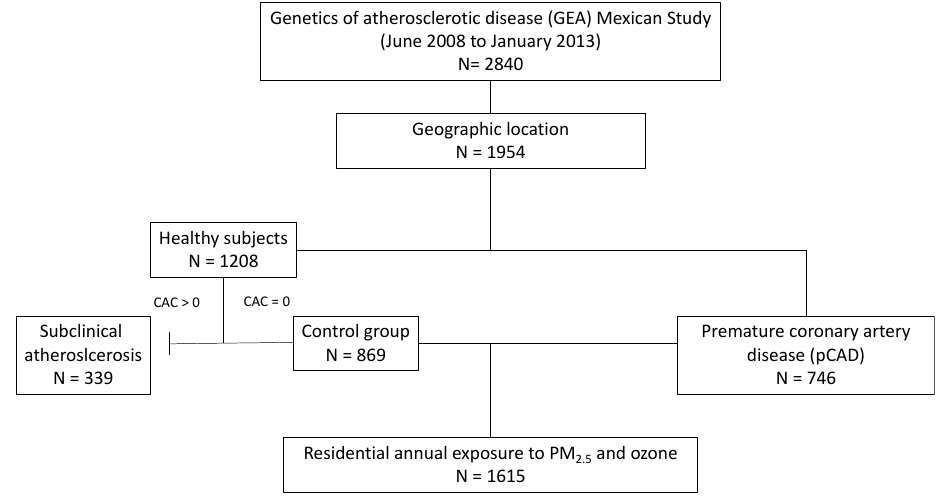
Figure 1. Flowchart for the study participants.